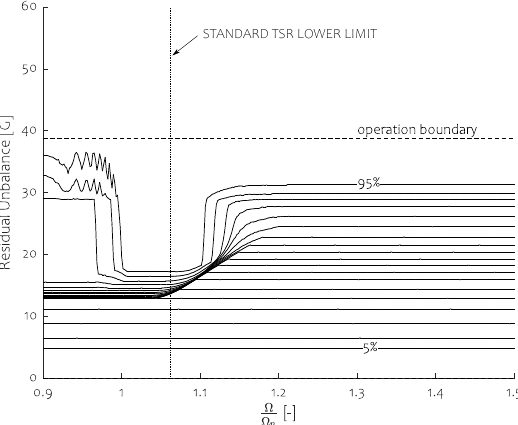
Figure 13. Effect of the lower speed plateau on the global balancing outcomes for G ini = 5, µ r = c r = 1. Effect of Initial Unbalance on Valid Speed Plateau Range